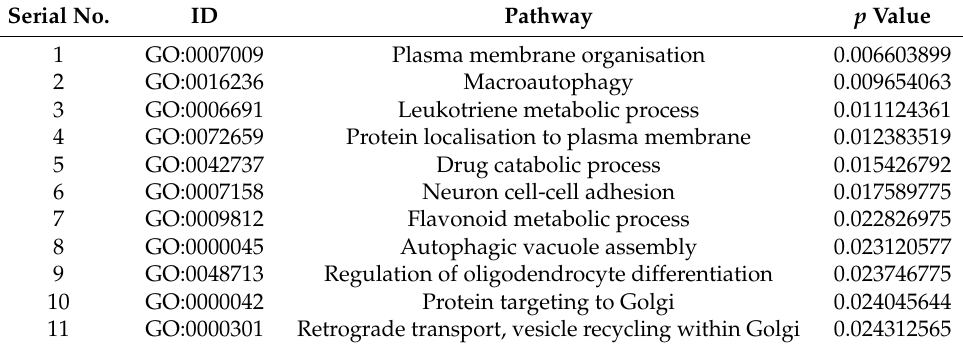
Table 4. Pathways enriched between NPEC versus NNAE using GO enrichment analysis. Serial